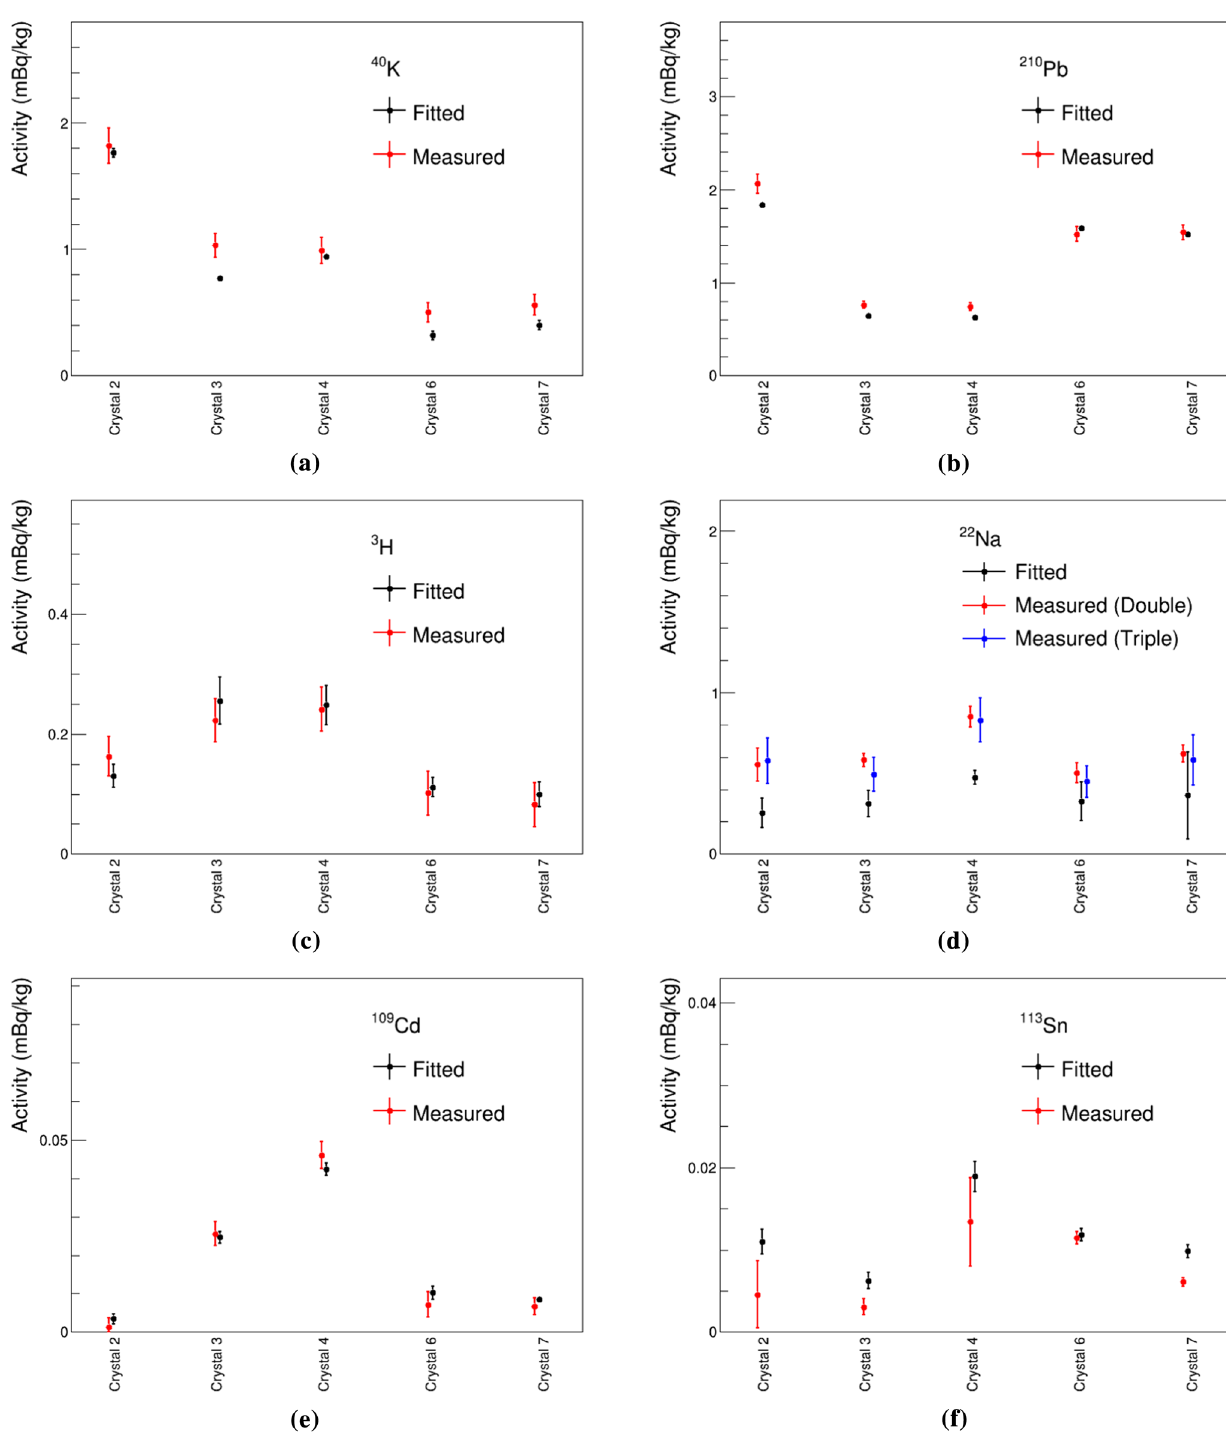
Fig. 8 Comparison of the measured [1,15,17] and the fitted activity levels of 40 K ( a ), 210 Pb ( b ), 3 H ( c ), 22 Na ( d ), 109 Cd ( e ), and 113 Sn ( f ) in five NaI(Tl) crystals. Double and Triple in d refer to the double/triple coincidence methods used in Ref.